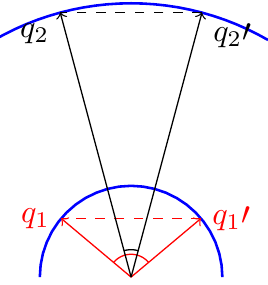
Figure 5. Equidistant chords on concentric scattering rings form the arcs in the q -space correlation